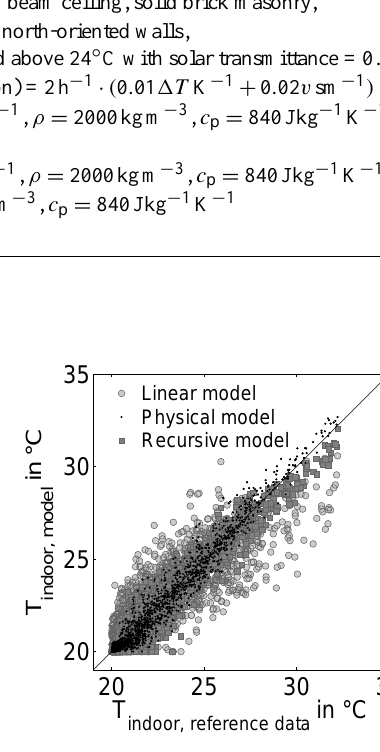
Figure 4. Calculated mean daily indoor temperature of parametrized linear, physical, and recursive building models according to Sec. 3.1 compared to the EnergyPlus simulation